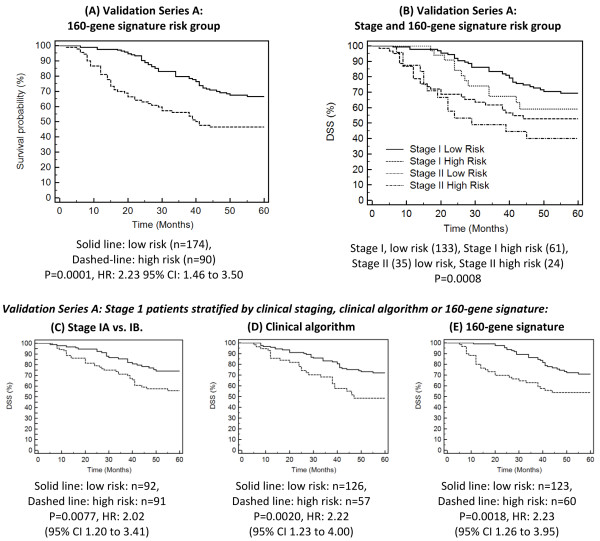
Kaplan Meier analysis of Validation Series A patients, stratified by gene expression risk group (A) and clinical stage (B). Kaplan Meier analysis was also performed on Stage IA patients from Validation Series A Stage stratified by AJCC stage (C), a clinical algorithm based on tumor size and age (D) and the 160-gene signature (C) for comparison purposes. The gene expression signature is able to more accurately identify stage I patients at risk of death within the first 24 months following diagnosis compared with clinical stage or combined clinical age + tumor size algorithm.